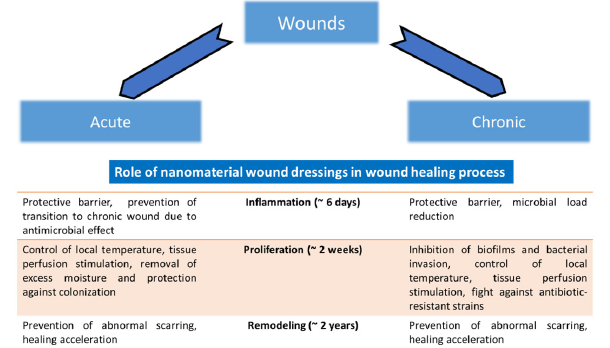
and non-soluble. Pharmaceutics 2020 , 12 , x